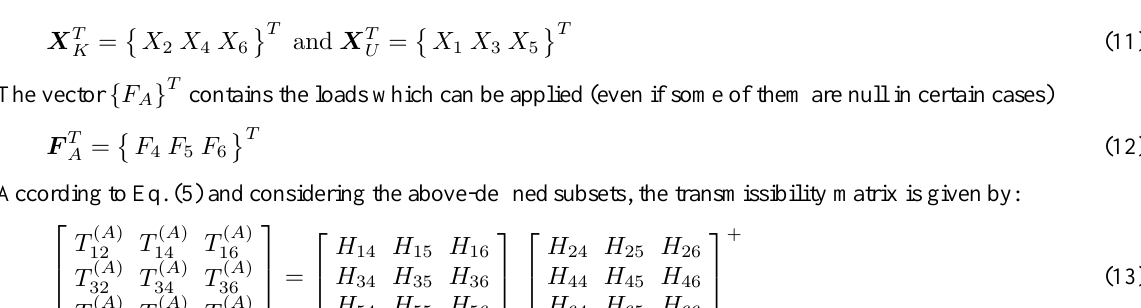
Fig. 6. Transmissibilities obtained for (a) original structure, (b) stiffness modified structure (SM) and (c) mass modified structure